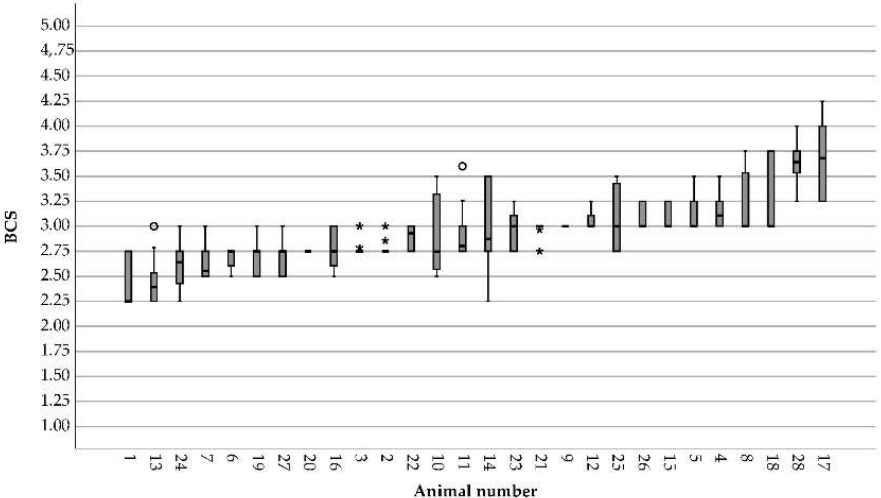
Figure 5. BCS data between weeks 2 and 15 postpartum (p.p.). In each subfigure, the boxplots respectively highlight the median, upper, and lower quartiles of each week. Box whiskers extended to the most extreme nonoutlier data points were considered as outliers if they lay more than 1.5 times the interquartile range from the edge of the box. Small circles = outliers (1.5 × interquartile range (IQR)); asterisks = extreme values (3 × IQR).